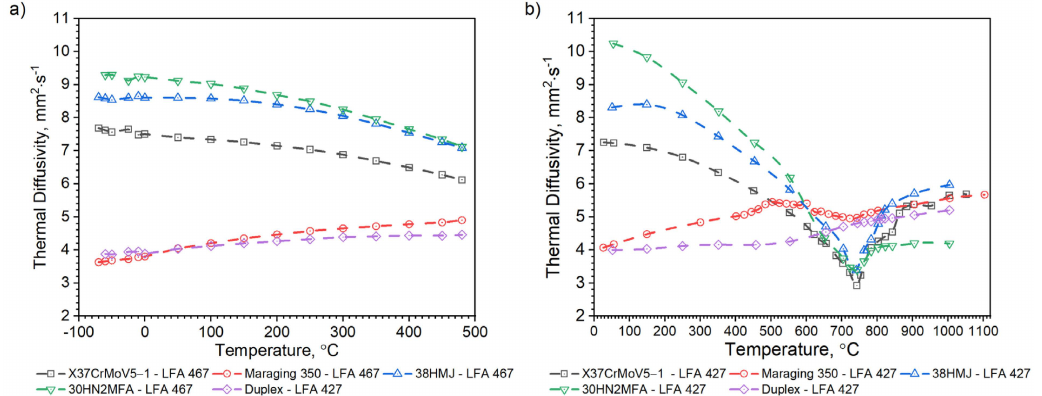
Figure 18. Comparison of thermal diffusivity measurements as a function of temperature for X37CrMoV5 − 1, Maraging 350, 38HMJ, 30HN2MFA and Duplex 2205 sheets of steel: ( a ) obtained